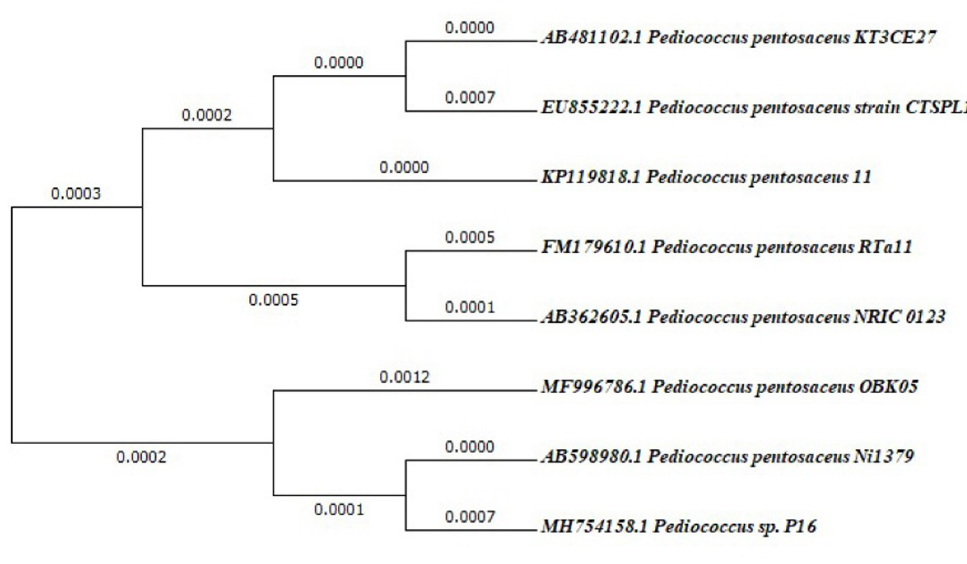
Fig 1. Phylogenetic tree representing the relationship of OBK05 with other members of Pediococcus spp.